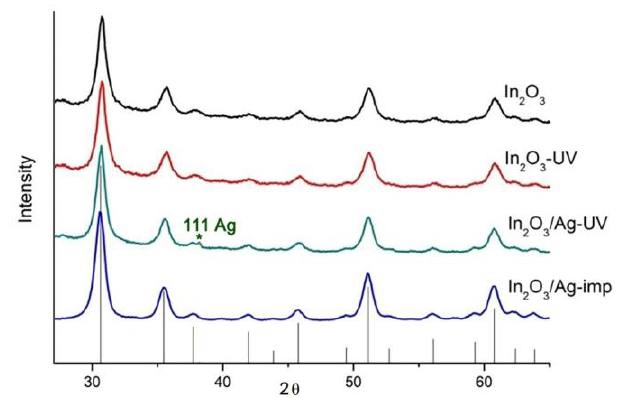
Figure 3. XRD patterns of synthesized powders. Vertical lines correspond to the ICDD 6-416 reference (In 2 O 3 bixbyite).